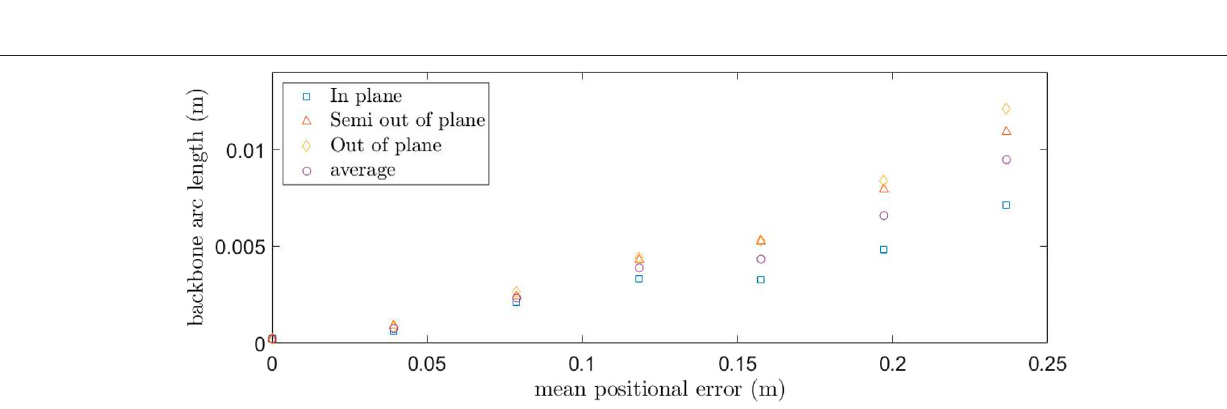
FIGURE 9 | Predicted and realized backbone position for the (A) In-Plane, (B) Semi-Out-of-Plane, and (C) Out-of-Plane tendon region. The table summarizes the tension combinations for the different points. Red lines indicate model prediction and circles indicate the OptiTrack observations.